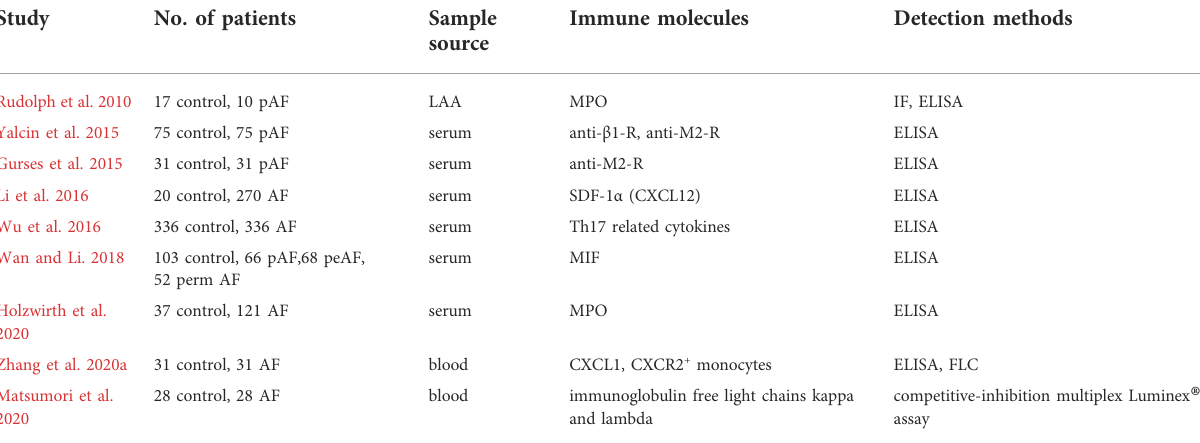
TABLE 2 The main studies on the change of special immune molecules in AF.